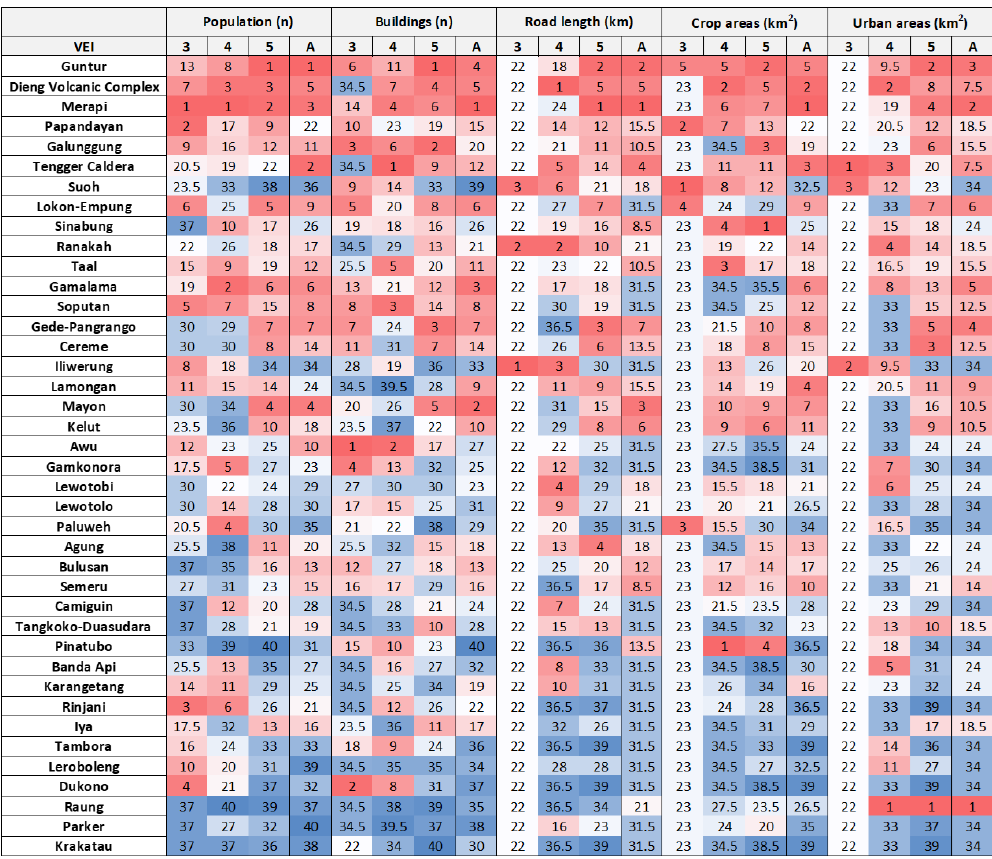
Figure 13. Individual rankings for calculated exposure using the 50% large clast hazard. Column names, volcano order and cell colour as for Fig.